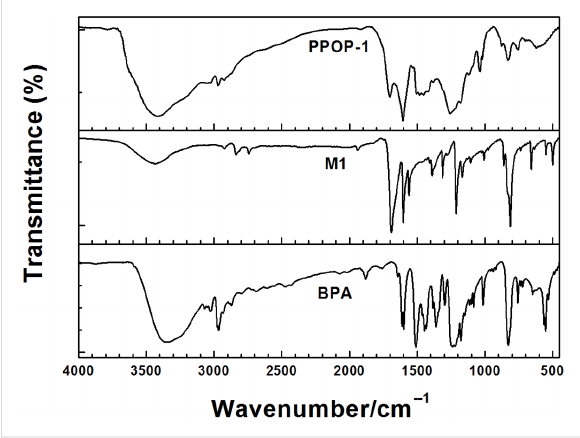
Figure 1: FTIR spectra of terephthalic aldehyde ( M1 ), BPA, and PPOP-1 .